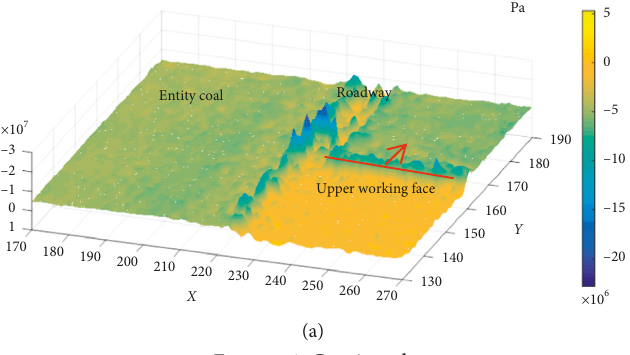
Figure 5: Vertical displacement and plastic zone in the GERPOHR and conventional mining method. (a) GERPOHR z-displacement. (b) GERPOHR plastic zone distribution. (c) Conventional mining z-displacement. (d) Conventional mining plastic zone distribution.